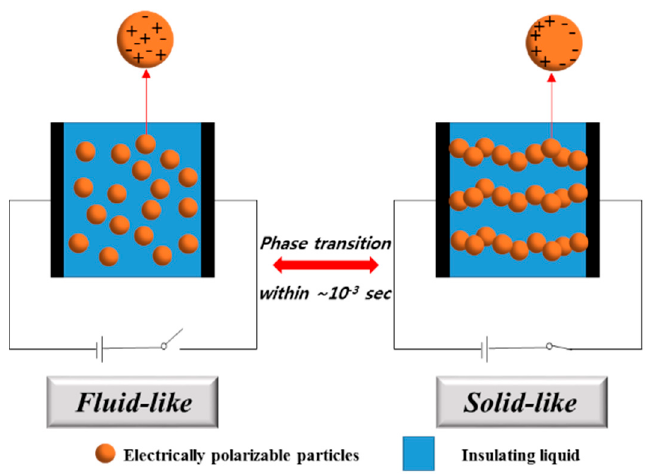
Figure 1. Schematic diagram of electrorheological (ER) behavior with an external electrical field.